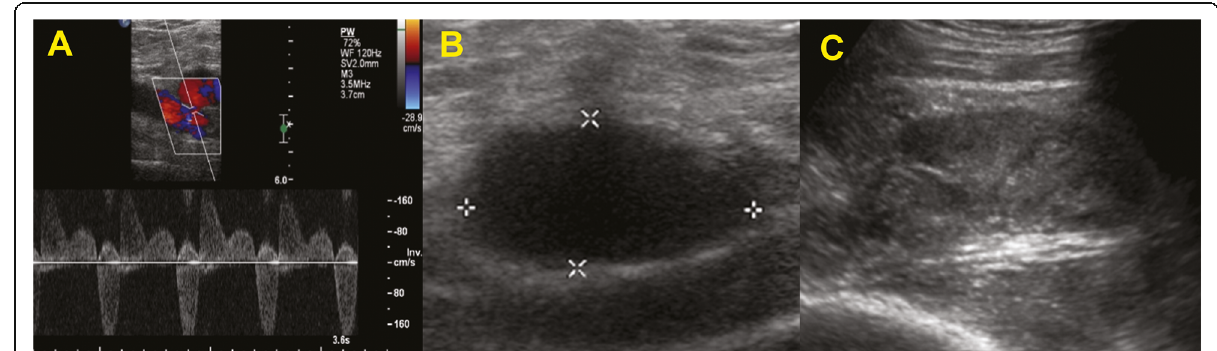
Fig. 1 a-c Pseudoaneurysm (PSA) embolized with thrombin. Doppler US view ( a ) of a common femoral artery PSA with a small neck. Pre-